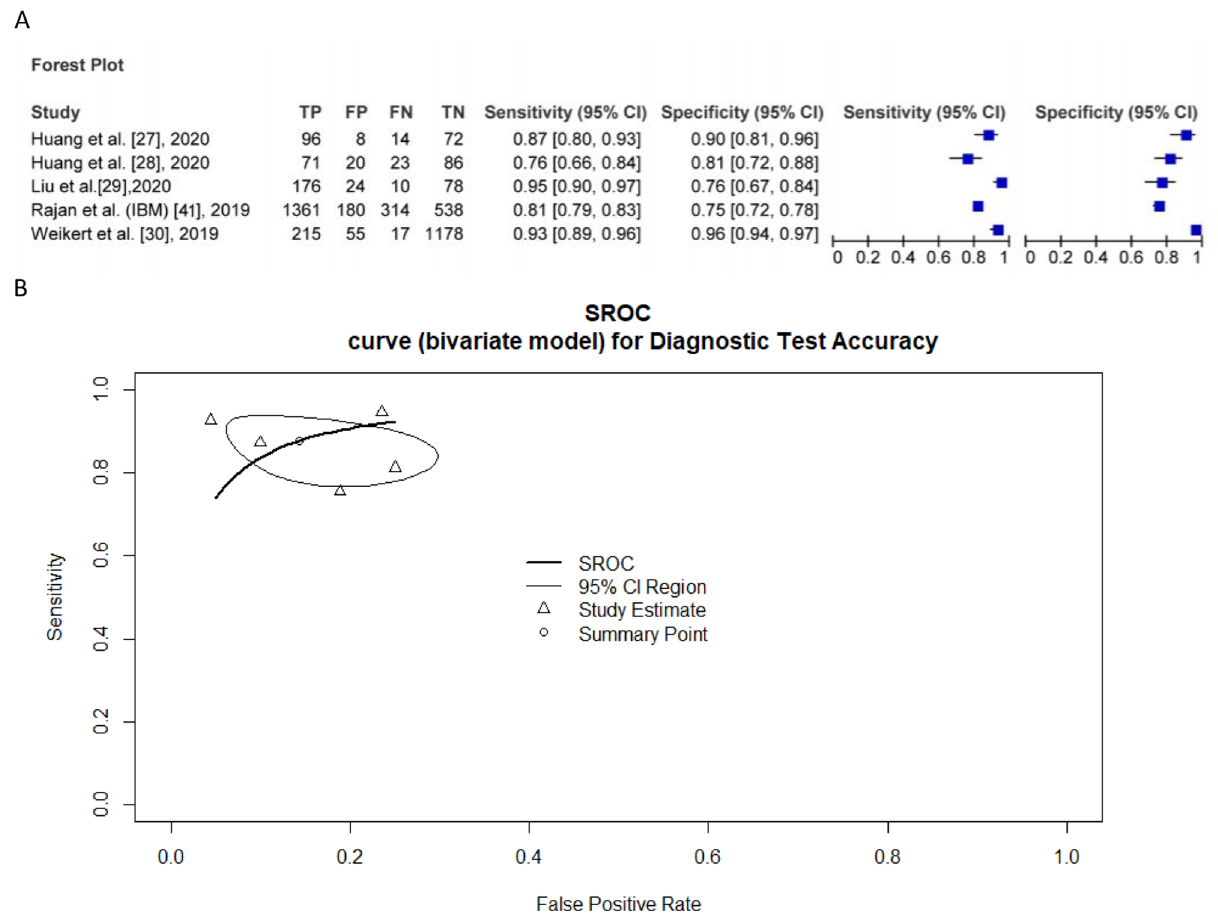
Figure 6. ( A ) Sensitivity and Specificity of included studies ( B ) Bivariate summary ROC curves for the detection of pulmonary embolism on CTPA using deep